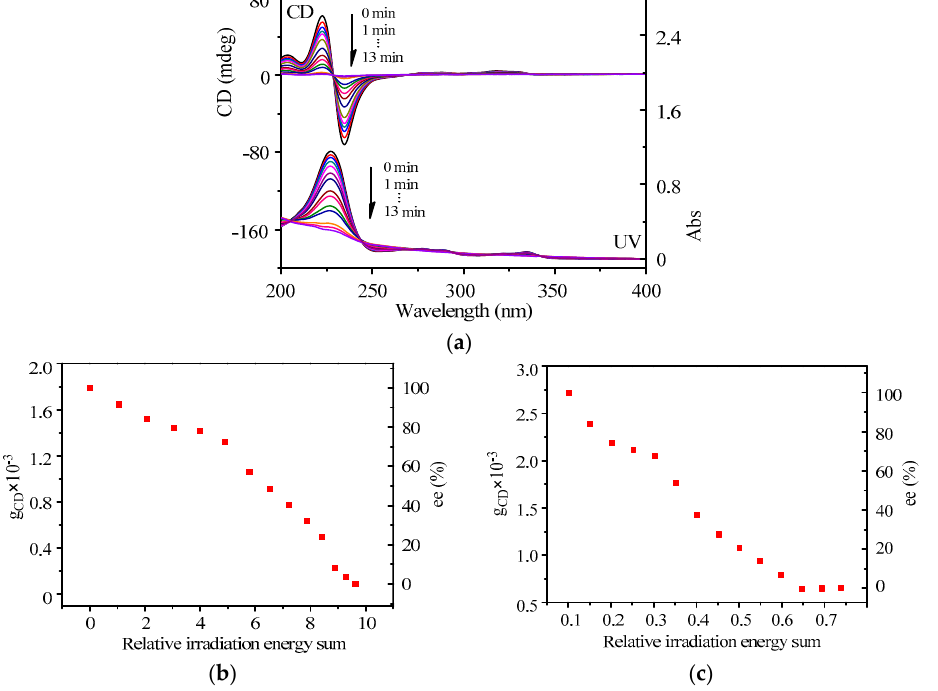
Figure 1. Changes in chirality of ( R )-BINOL in CH 3 CN solution upon irradiation ([BINOL] o = 1.0 × 10 − 4 M, cell path 1 mm, room temperature): ( a ) CD and UV spectra taken upon irradiation for 13 min at 1-min interval; ( b ) g CD -vs.-relative irradiation energy plot at 223 nm; ( c ) g CD -vs.-relative irradiation energy plot at 318 nm.